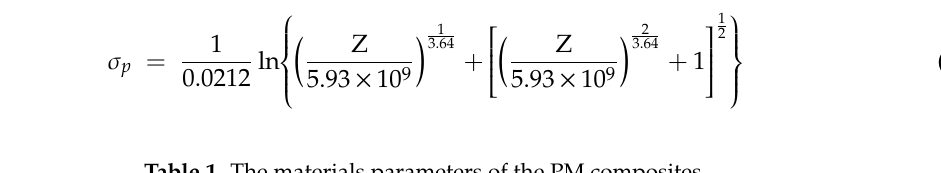
Table 1. The materials parameters of the PM